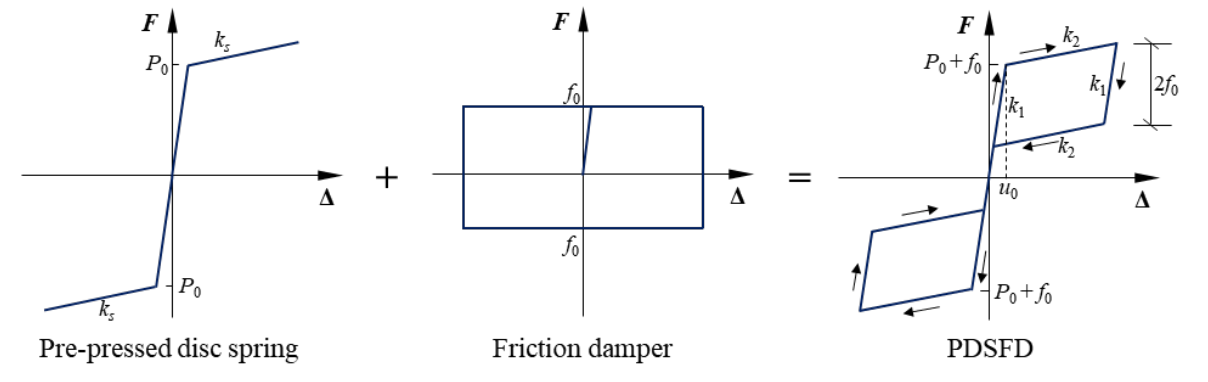
Figure 3. Hysteretic curve of PDSFD.